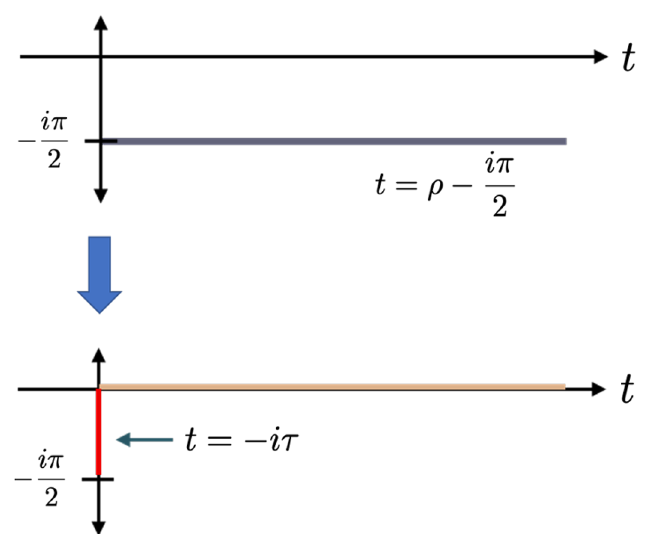
Figure 9 . Depiction of the change of complex time contour to go from the Hartle-Hawking geometry in Lorentzian nearly-dS 2 in ( (cid:0) ; +) signature to the disk in Euclidean nearly-AdS 2 in ( (cid:0) ; (cid:0) ) signature.